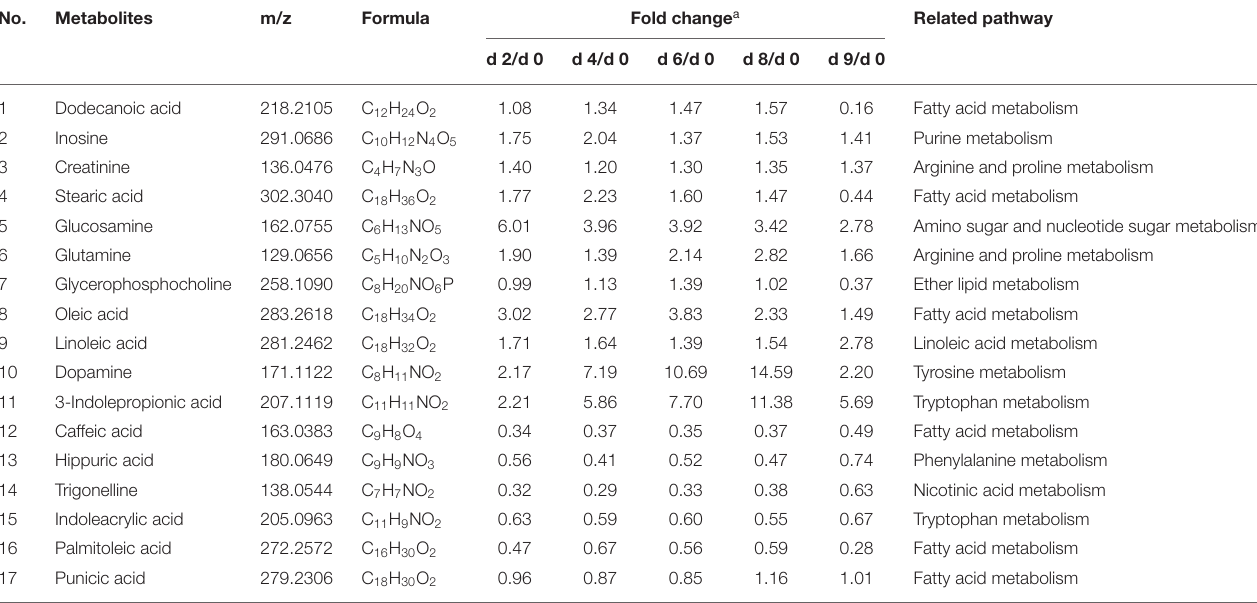
TABLE 3 | Effects of feeding level at metabolizable energy for maintenance on the concentration of plasma biochemical parameters in growing pigs.